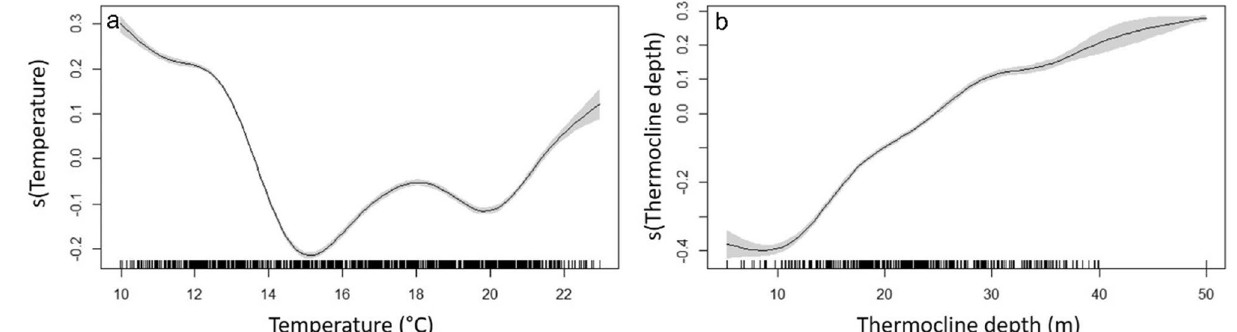
Figure 7. Results of the GAMM models on the fish depth during the study period. Effect of seawater temperature (at 15 m depth) ( a ) and thermocline depth ( b ). Lines represent the estimated smoothing curves from each model and shaded areas represent the 95% confidence interval for the mean shape of the effect.